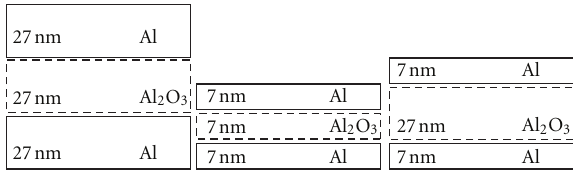
Figure 3: Diagram representing Layer Maker application